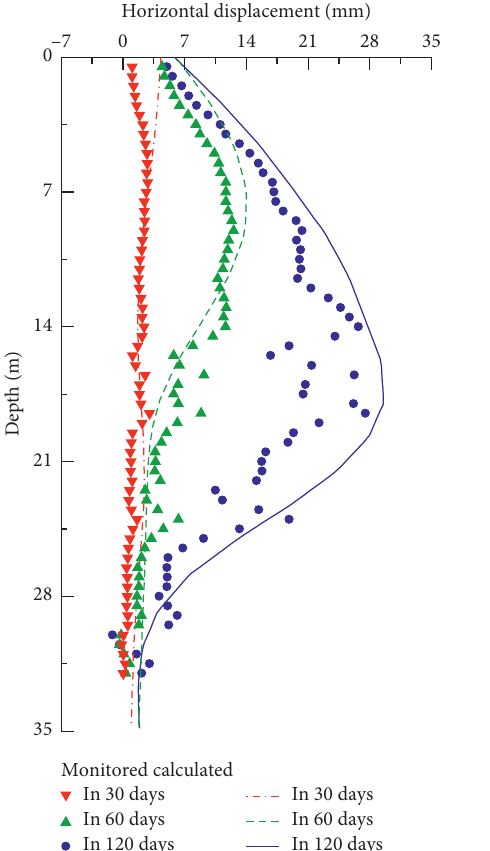
Figure 8: Lateral displacement of retaining pile body.